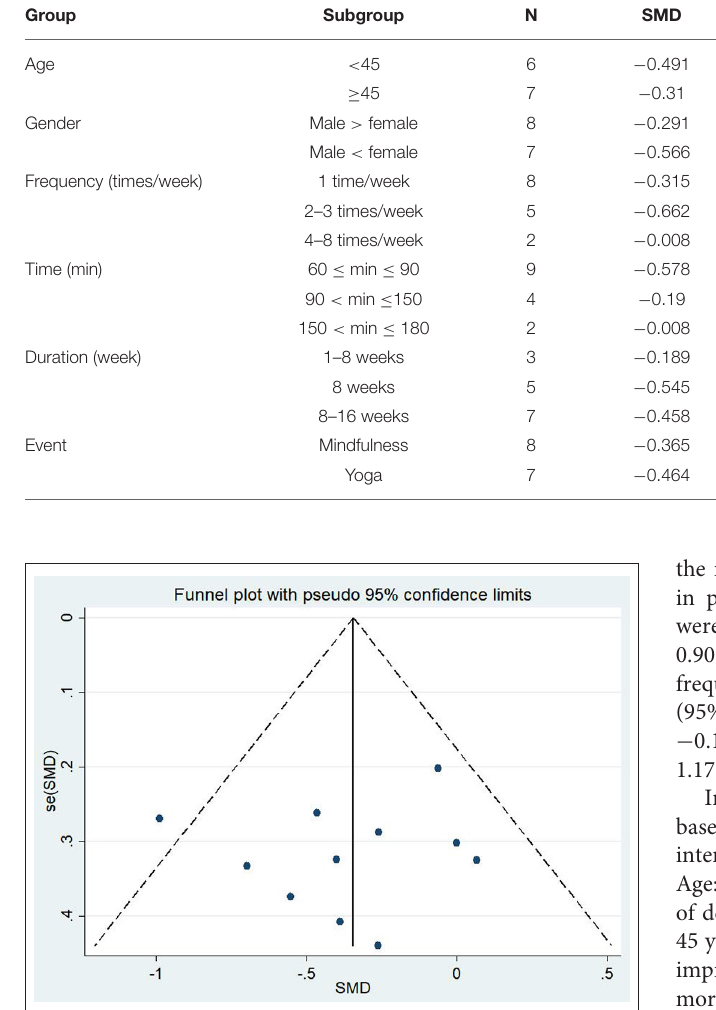
FIGURE 4 | Funnel plot of publication bias for